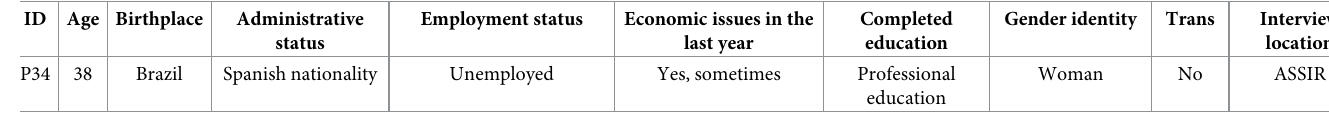
and free bleeding (9.1% vs 3.5%).